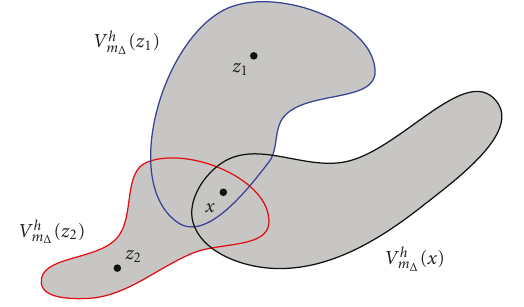
Figure 5: Example of adaptive R h and nonadaptive B r structur- m (cid:3) ing elements with three values both for the homogeneity tolerance , and for the disks radius r . The shapes of B r ( x 1 ) and parameter m (cid:0) B r ( x ) B r ( x 2 ) are identical and r is a family of homothetic sets for (cid:0) (cid:2) ( x 3 ) and each point x D . On the contrary, the shapes of R h m (cid:3) (cid:3) ( x 4 ) are dissimilar and ( x ) is not a family of homo- R m R h m m (cid:0) (cid:2) (cid:3) (cid:3) (cid:3) thetic